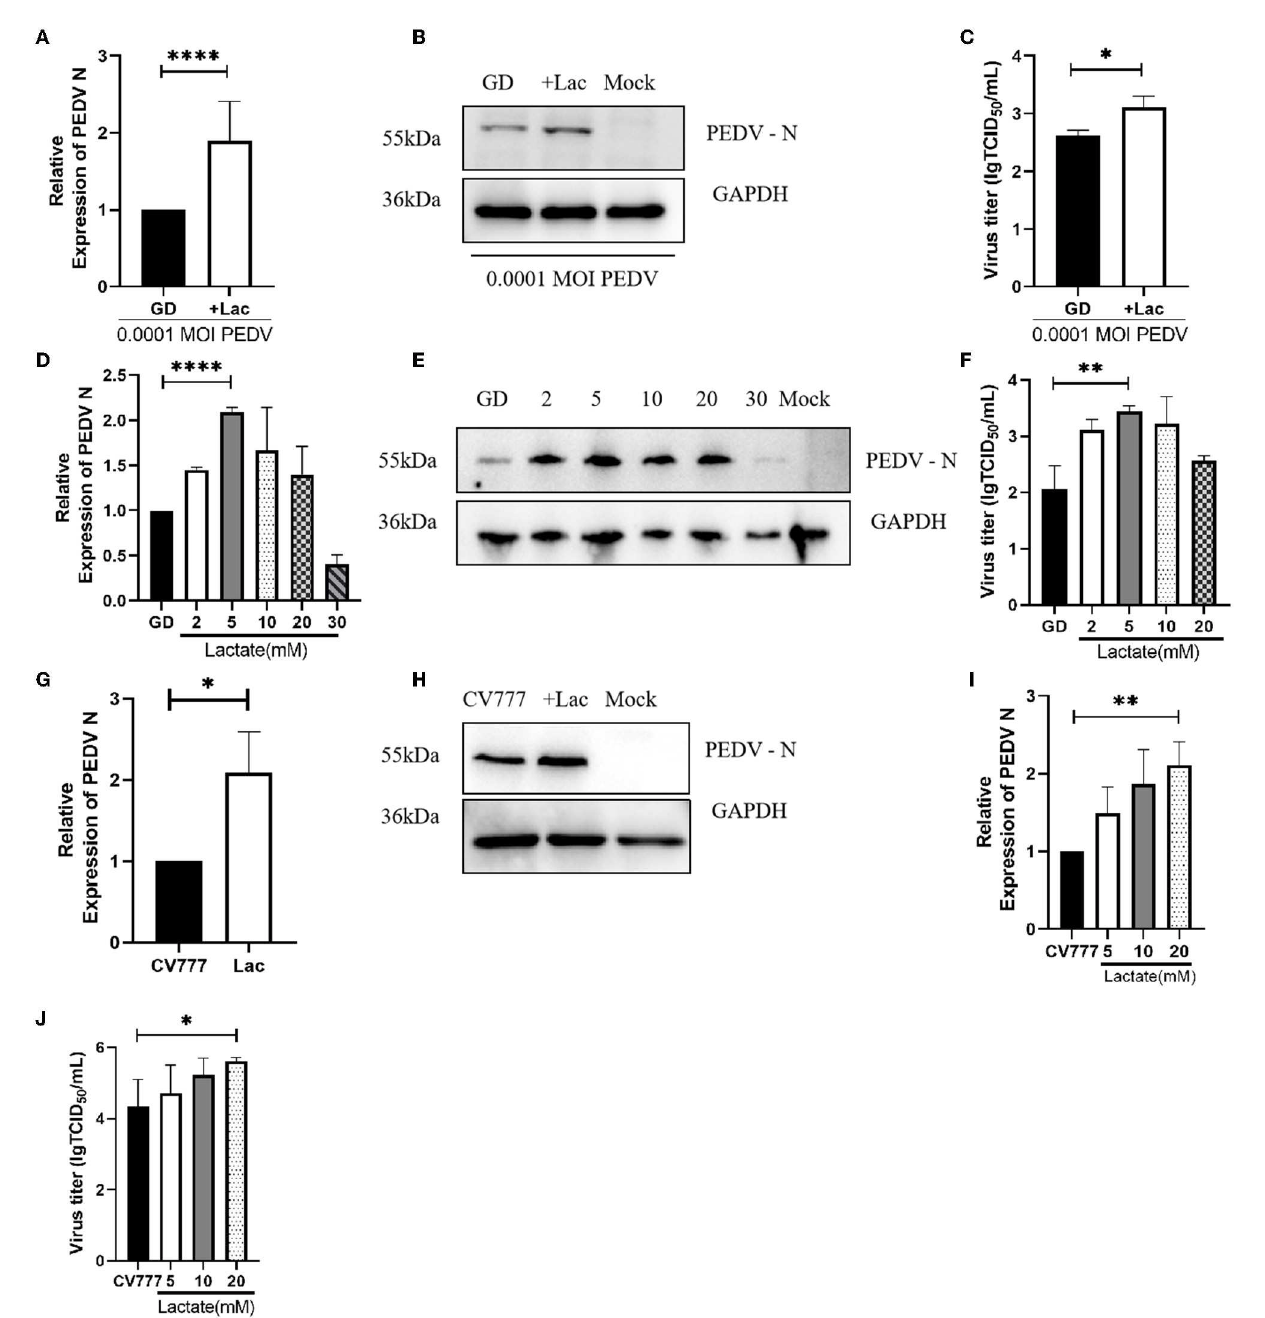
FIGURE3 The promoting effect of lactate on different strains of PEDV is concentration-specific. Analysis of PEDV N mRNA levels (A) , protein levels (B) , and viral titers (C) in Vero cells grown in normal DMEM supplemented with 10mM lactate and infected with 0.0001 MOI PEDV GD/HZ/2016 strain. (D–F) The effect of the supplementation of normal DMEM with 2, 5, 10, 20, and 30mM lactate on the replication of PEDV GD/HZ/2016 strain, as shown by the analysis of the PEDV N mRNA levels (D) , protein levels (E) , and viral titers (F) in Vero cells. The addition of 10mM lactate to normal DMEM promoted the replication of PEDV CV777 strain, as shown by the PEDV N mRNA (G) and protein levels (H) . (I, J) The increase in the PEDV CV777 replication on addition of 5, 10, and 20mM lactate to normal DMEM was found to be concentration-dependent, as shown by the PEDV N mRNA levels (I) and viral titers (J) . * p < 0.05; ** p < 0.01; **** p <